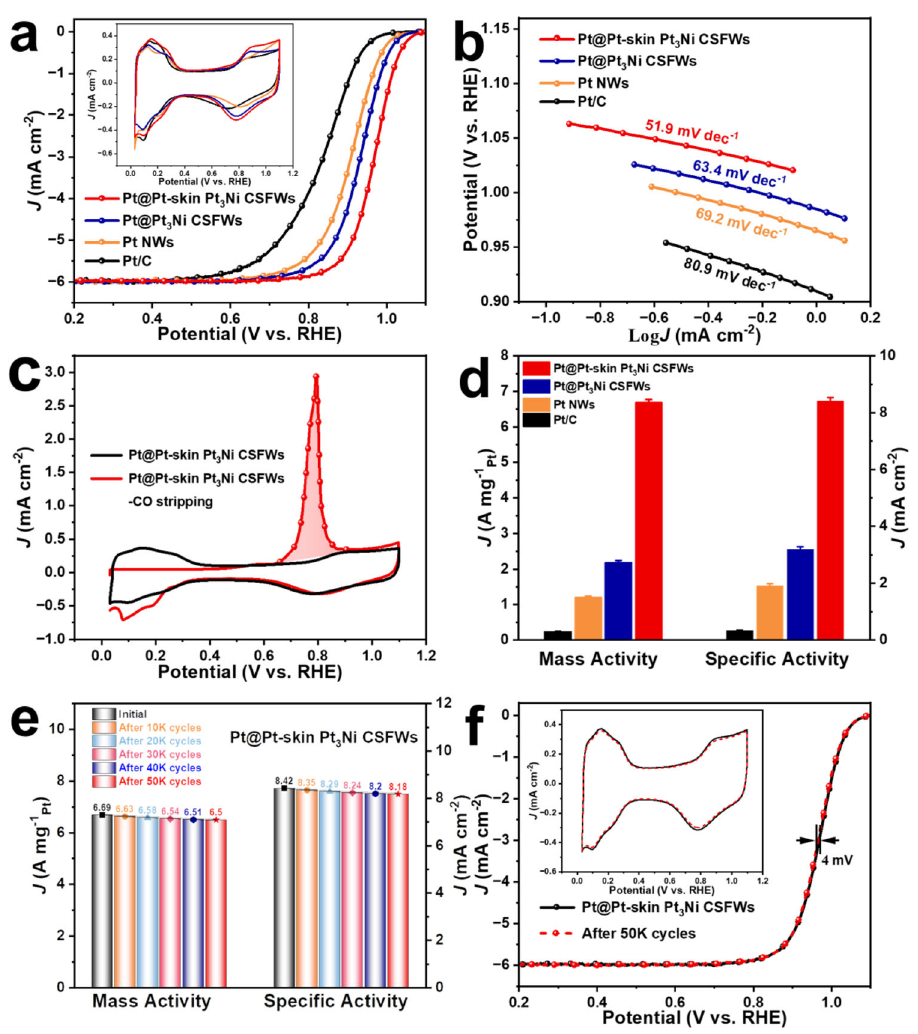
Fig. 4 | Electrocatalytic performance of mesoporous Pt@Pt-skin Pt 3 Ni CSFWs/ C, Pt@Pt 3 Ni CSFWs/C, Pt NWs/C, commercial Pt/C catalysts for ORR. a ORR polarizationcurves.TheinsetistheCVsofvariousPt-basedcatalystsin0.1MHClO 4 solution at a sweep rate of 50 mV/s. b Corresponding Tafel plots. c CV and CO stripping curves of mesoporous Pt@Pt-skin Pt 3 Ni CSFWs/C. d Mass and speci fi c activities at 0.9 V (versus RHE). The error bars in d are calculated based on fi ve